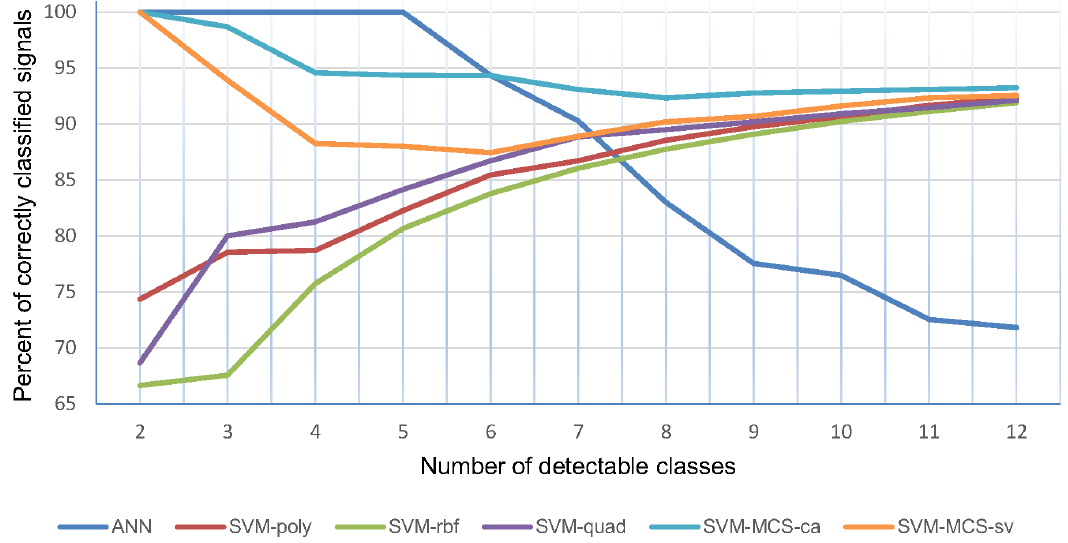
Figure 8. Comparison of classification results for all test groups. A comparison of accuracy of all tested methods (being: ANN – Artificial Neural Network, SVM-poly – Support Vector Machine with polynomial kernel function, SVM-rbf – Support Vector Machine with radial basis kernel function, SVM-quad – Support Vector Machine with quadratic kernel function, SVM-MCS-ca – Support Vector Machine with the Modified Cuckoo Search optimizer and classification accuracy fitness function) for a different number of recognizable classes. The SVM-MCS-ce method shows overall the best quality of classification. doi:10.1371/journal.pone.0112673.g008 PLOS ONE |